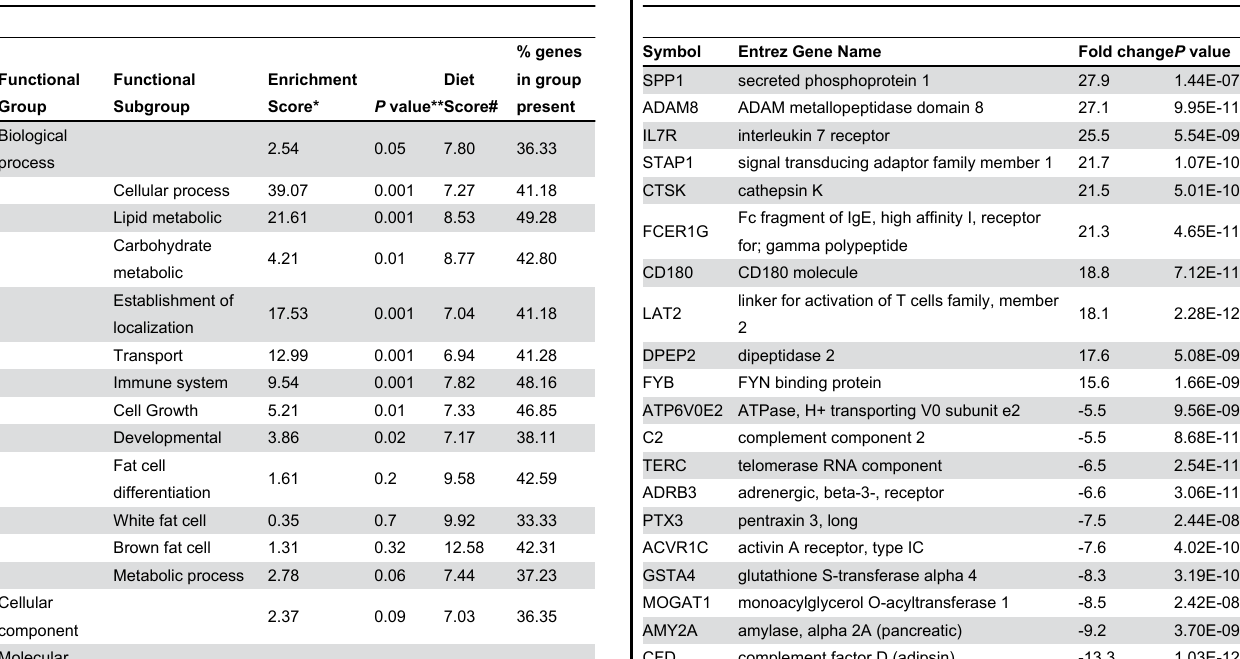
Table 2. Gene ontologies with differentially expressed genes in response to high fat diet.